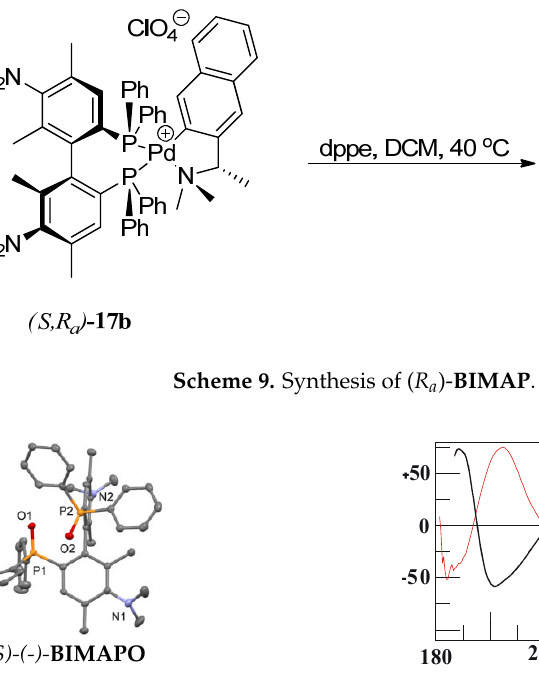
Figure 6. X ‐ ray structure of (S) ‐ ( ‐ ) ‐ BIMAPO (solvent molecule and hydrogen atoms were omitted for clarity), its CD spectrum (black) as well the CD spectrum of (R) ‐ MeO ‐ BIPhEPO